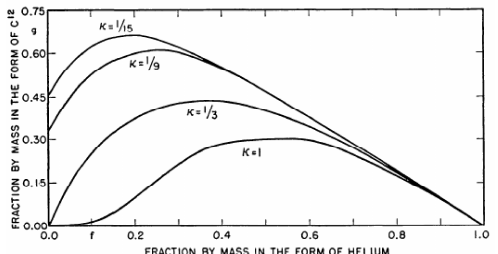
Figure 8.16: The formation of carbon from helium as a Figure 11: The argument by Hoyle that the resonance function of Hoyle’s parameter  . This is the figure which must convinced Hoyle that 12 C should have a resonance.